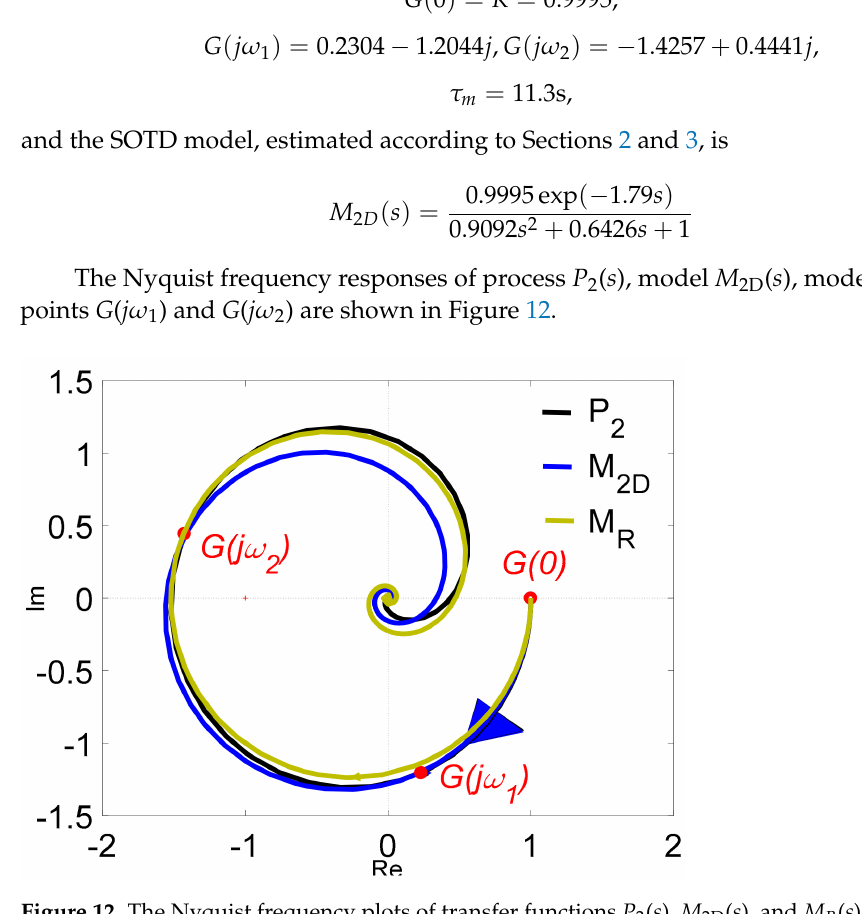
Figure 12. The Nyquist frequency plots of transfer functions P 2 ( s ), M 2D ( s ), and M R ( s ). The unit step responses of process P 2 ( s ) and models M 2 ( s ), M 2D ( s ), and M R ( s ) are shown in Figure 13.